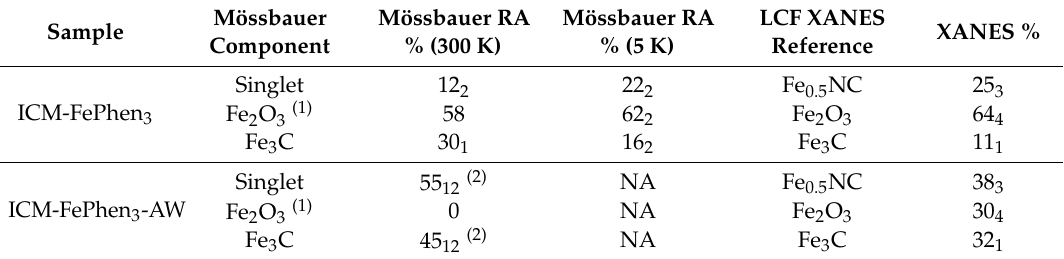
Table 2. Content of each Fe species as obtained from the fitting of 57 Fe Mössbauer or Fe K-edge XANES spectra. Subscript number after the RA% or XANES % number indicates the error bar, in